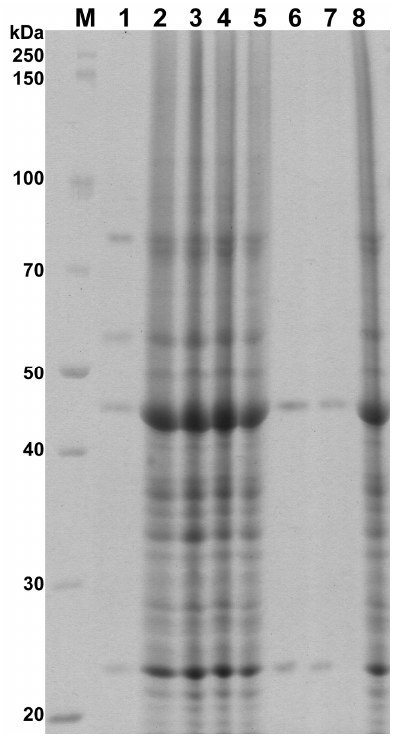
Figure 3. Protein profiles of different Candida albicans ATCC 10231 morphotypes, after treatment with peppermint oil (PO) and clove oil (CLO); M —marker (PageRuler Broad Range Unstained Protein Ladder, Thermo Scientific); 1 —PO/0.25; 2 —PO/0.015; 3 —PO/0.0075/1; 4 —PO/0.0075/2; 5 —control; 6 —CLO/0.25; 7 —CLO/0.125; 8 —CLO/0.0075. Acronyms are composed as follows: essential oil type/oil concentration/isolate number (if any).